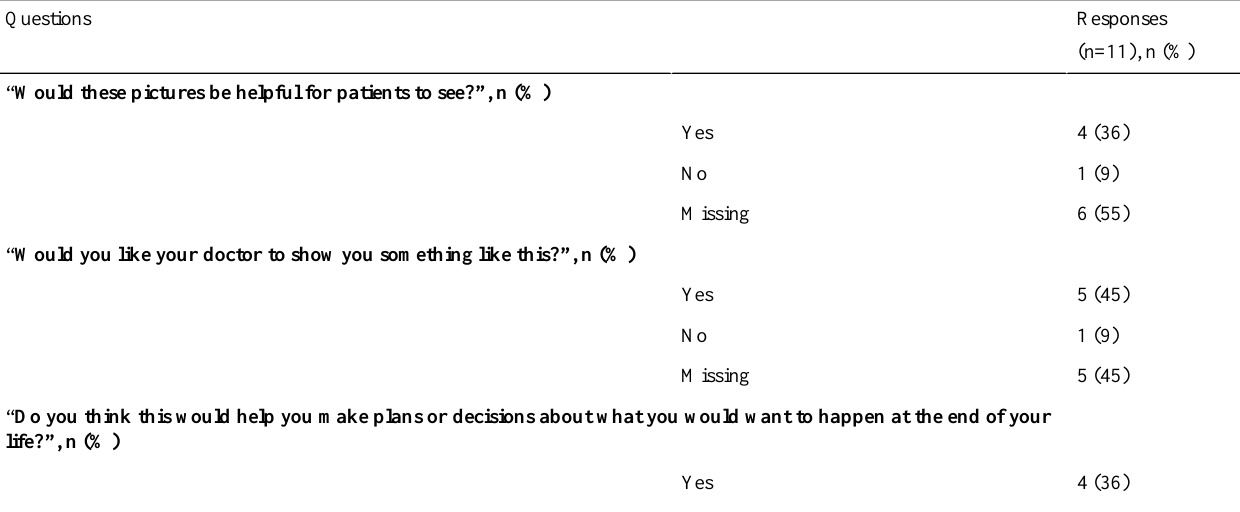
Table 2. Results of patient interviews from phase 1 of usability testing.